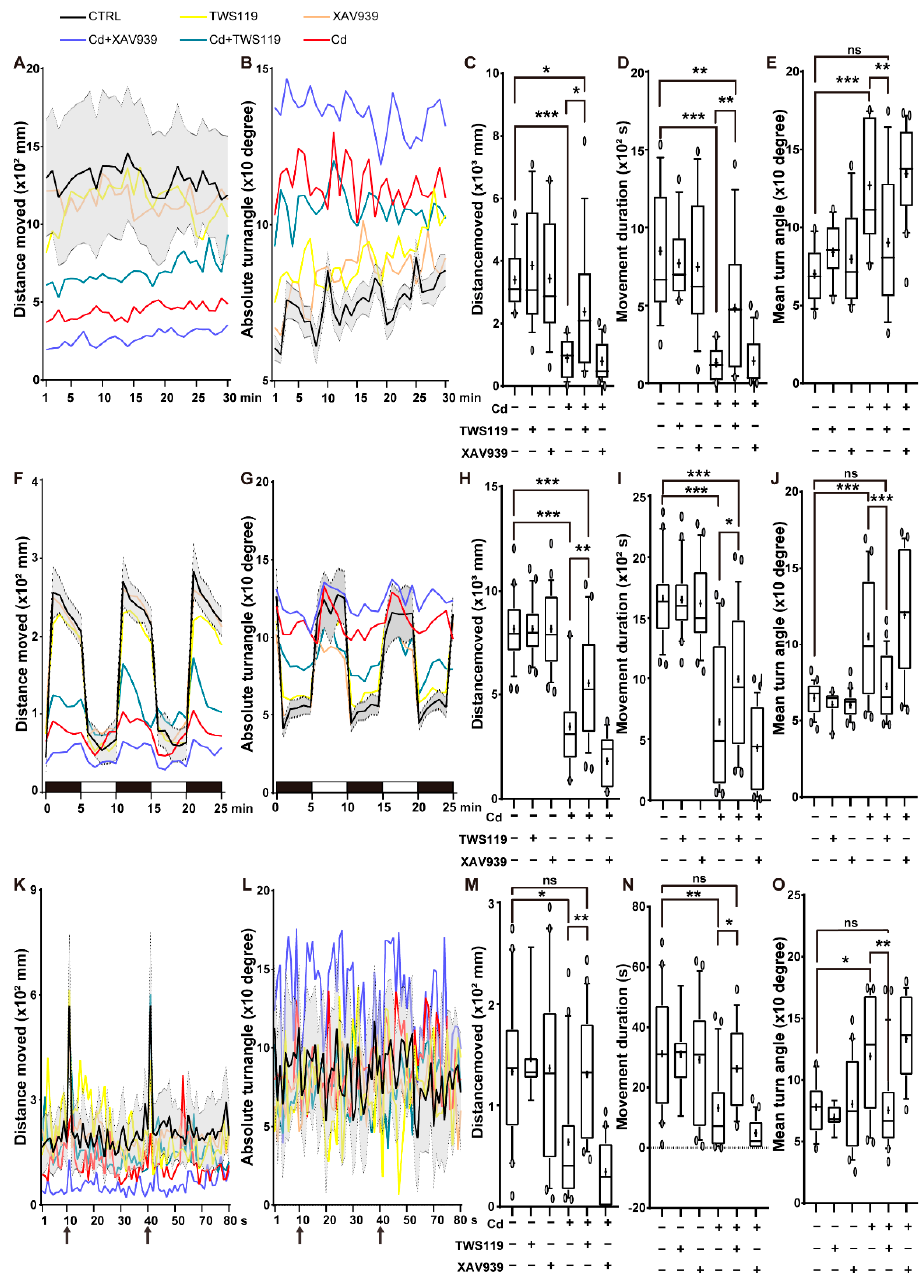
Figure 3. Patterns of zebrafish locomotor activities and reactivity to light–dark/vibration stimulation. Swimming distance, velocity of 6 dpf zebrafish larvae in open field tests ( A – E ), subjected to light–dark cycles ( F – J ) and vibration stimulation (as indicated by the arrows) ( K – O ). Panels ( A , B , F , G , K , L ) were plotted in 5 min/10 s time interval, panels ( C – E , H – J , M – O ) were plotted with average values of the whole-tracking. Each test was performed at least three times. The numerical values are presented in line charts or boxplots (median and mean, whiskers show 90% confidence levels). The results of either nonparametric test or ANOVA followed by multiple comparison test are listed in Table S2. “*” indicates significant differences (* p < 0.05, ** p < 0.01, *** p < 0.001).